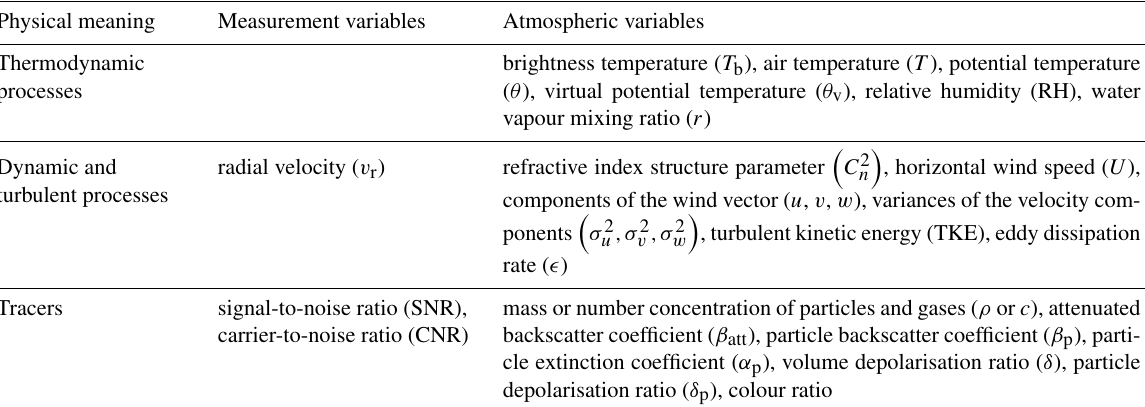
Table 1. Atmospheric variables analysed for the detection of ABL heights are relevant for thermodynamic and dynamic processes or act as atmospheric tracers. Measurement variables provide information on the probed atmosphere but are strongly dependent on sensor character- istics or measurement setup. Depending on the measurement technology, variables are directly observed, retrieved from measurements or calculated. Note: humidity can also be interpreted as an atmospheric tracer but is here grouped with air temperature due to its importance for thermodynamic processes. Based on the variables listed here, other higher-order variables or parameters can be calculated (such as turbulent fluxes or Richardson numbers) that are valuable for characterising the ABL, for example where observations from multiple systems are available for synergy